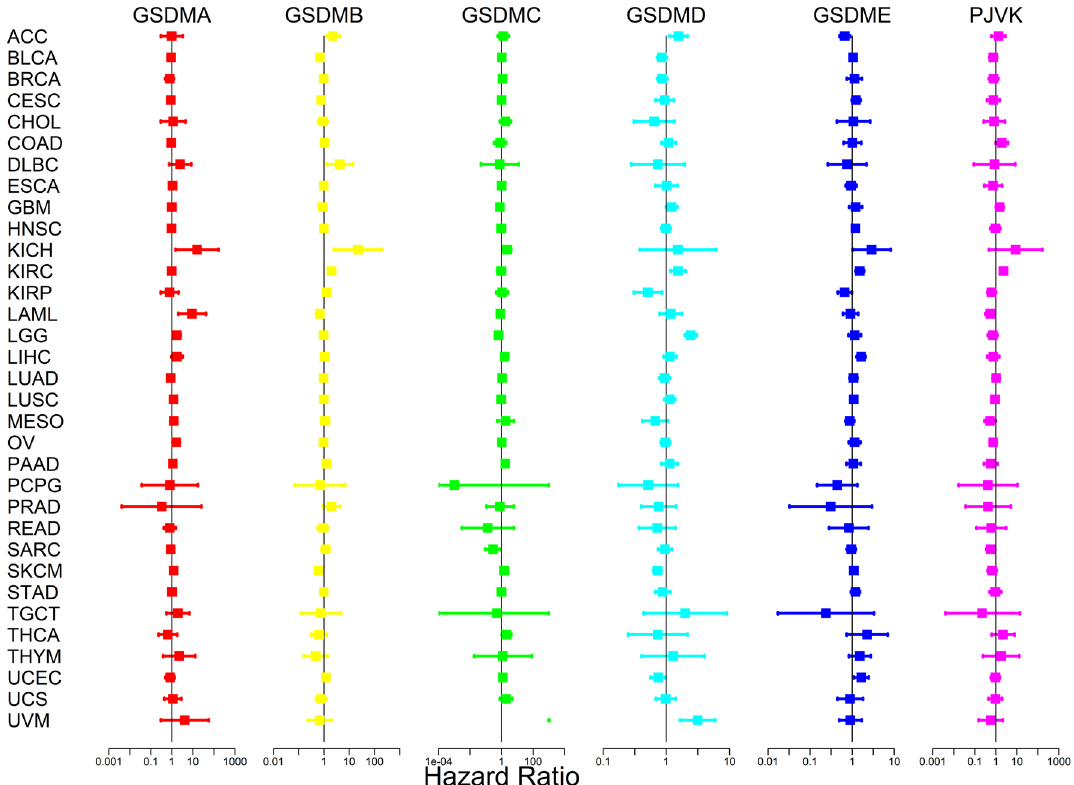
Figure 5. Univariate Cox proportional hazard regression showing correlations of gasdermin family gene expression with overall survival in pan-cancer; High risk was denoted by a hazard ratio > 1, whereas low risk was denoted by a hazard ratio <